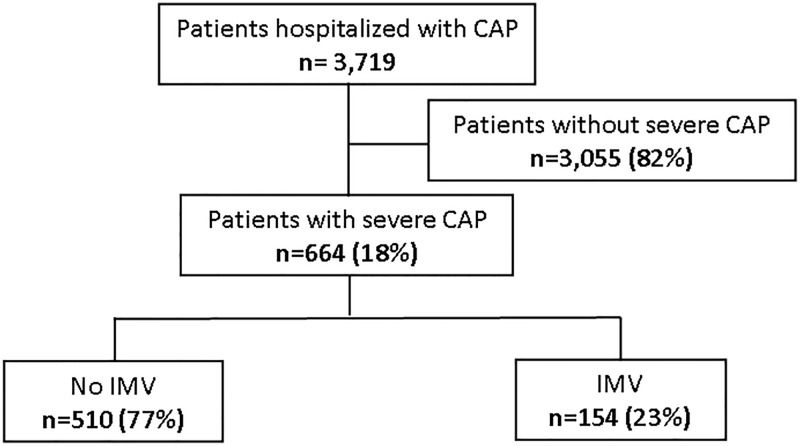
Flow diagram of the study population.